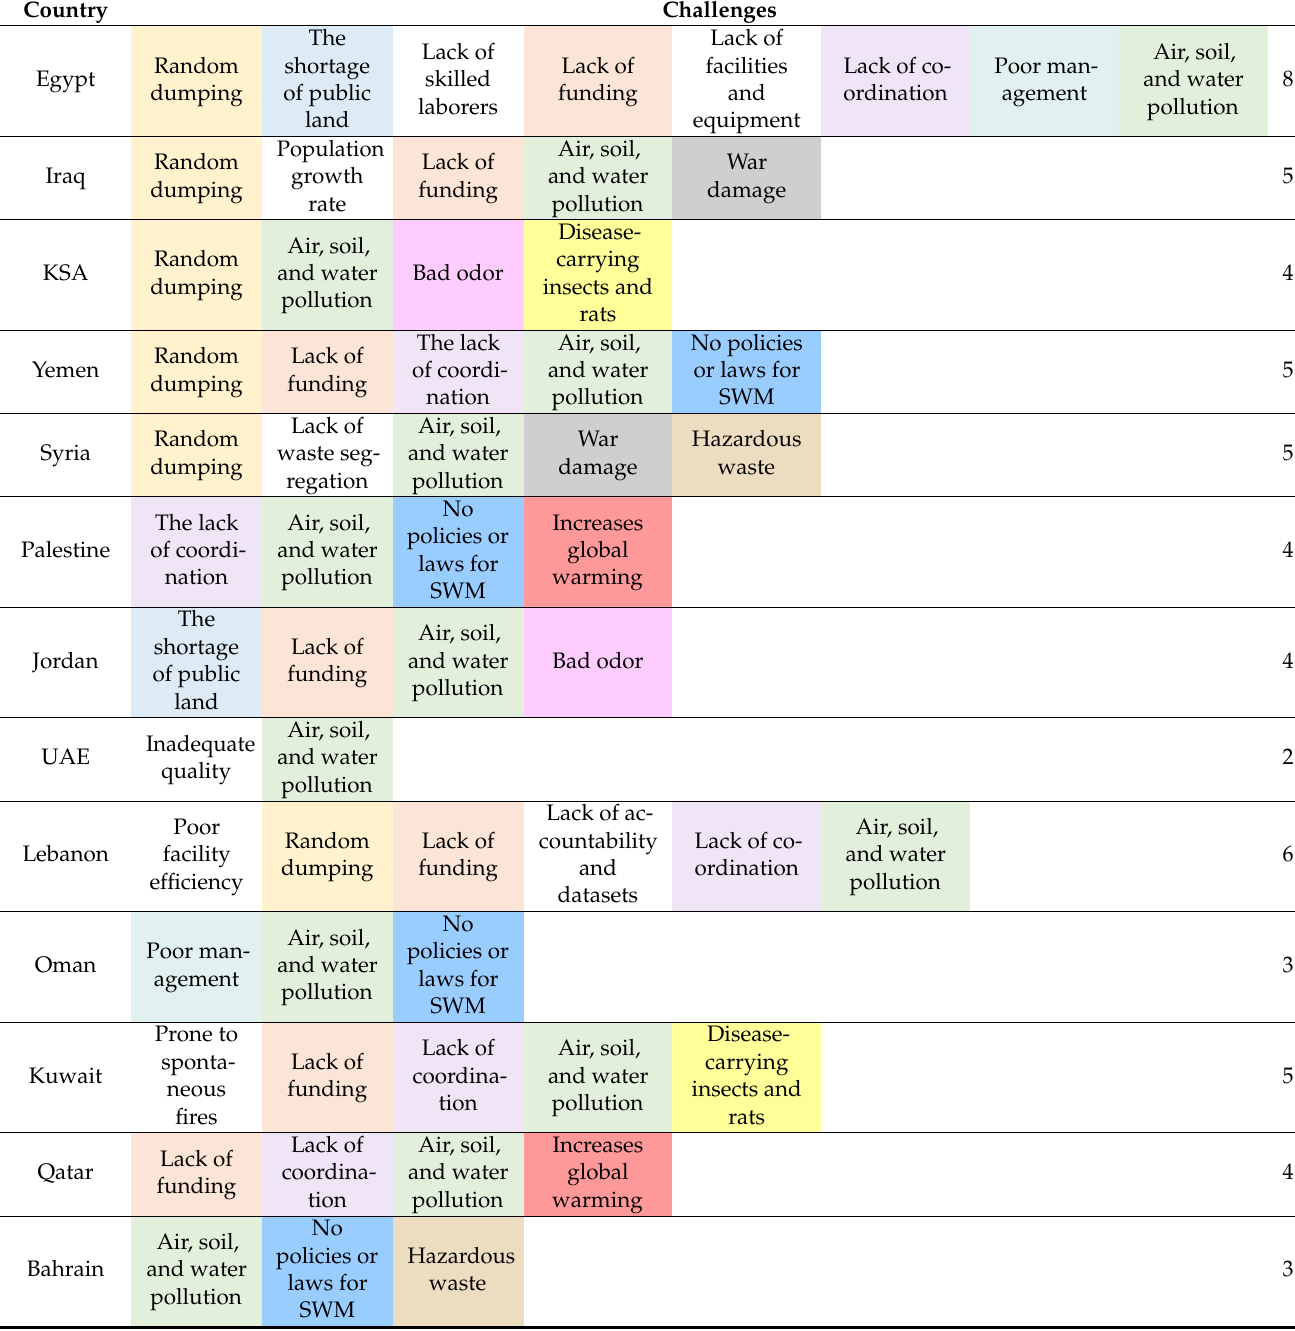
Table 1. SWM-related challenges faced by Arab countries